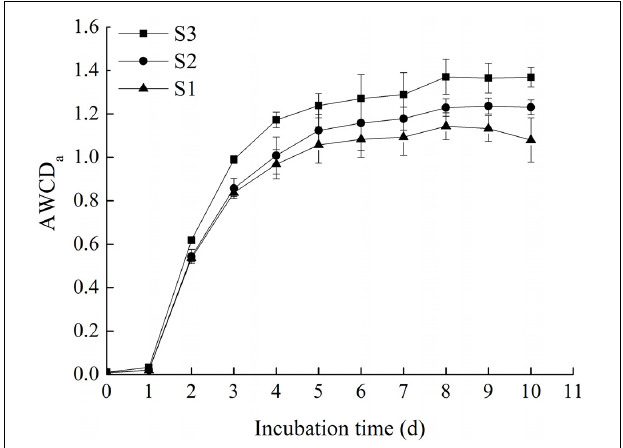
FIGURE 1 | The AWCD of all carbon sources in stored rice microbial communities within incubation time (the original data available in Supplementary Table